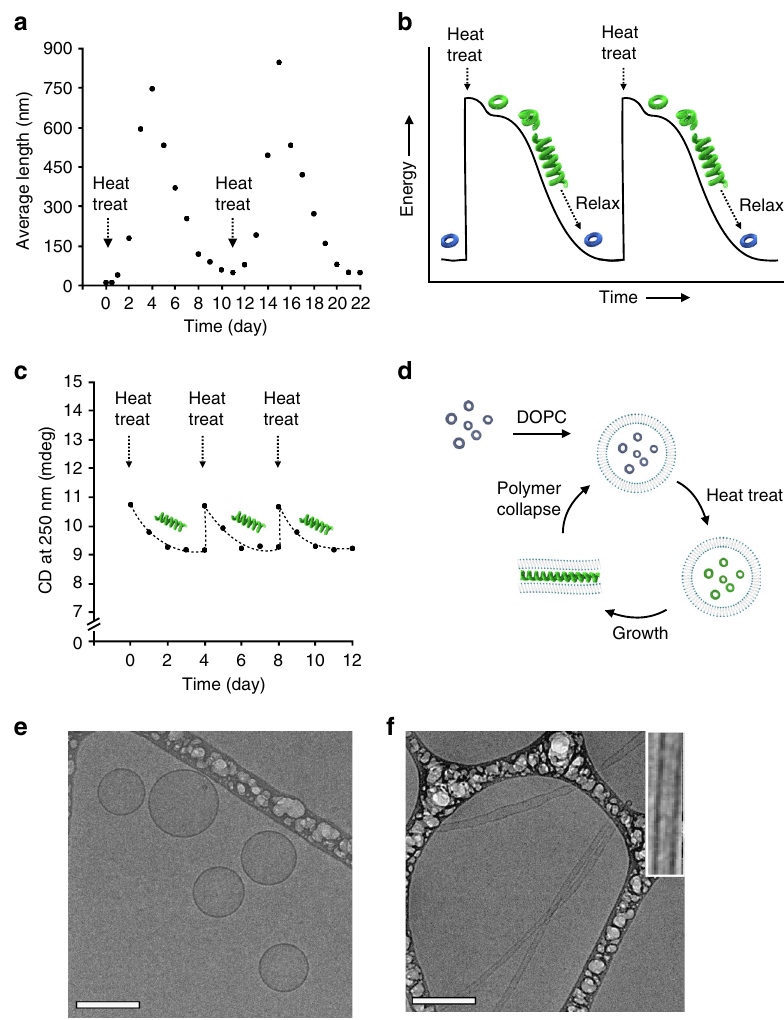
Fig. 4 Repeated polymerization and actuation of toroid-containing vesicles. a Average chain lengths as a function of time, counted from cryo-TEM ( n = 100). The subsequent heat treatments lead to identical polymerization and depolymerization cycles without sacri fi cing the response ef fi ciency to